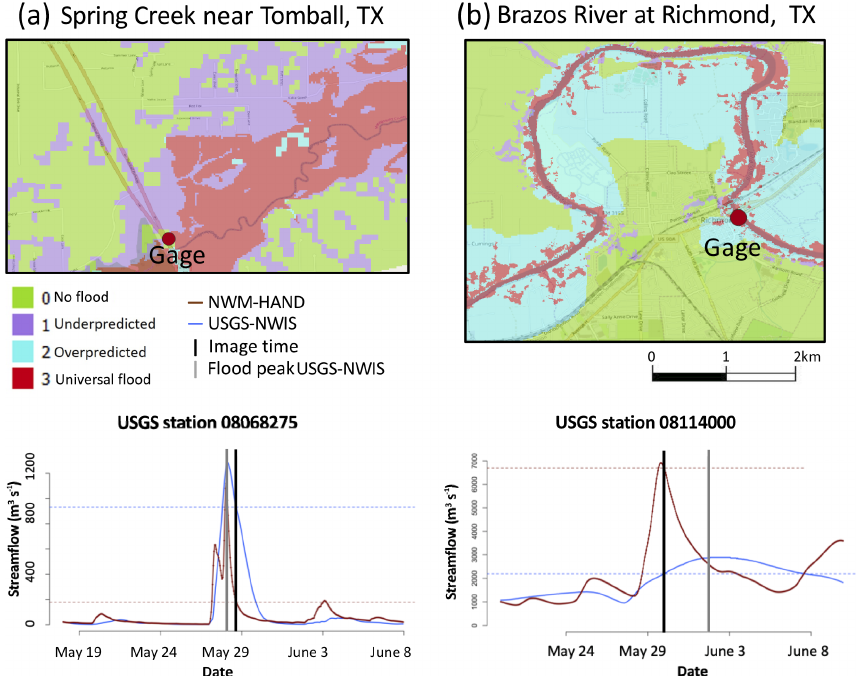
Figure 5. Prediction errors due to NWM flow forecast when nMAE exceeds 60%: (a) NWM underprediction results in underpredicted flood extents. (b) NWM overprediction results in overpredicted flood